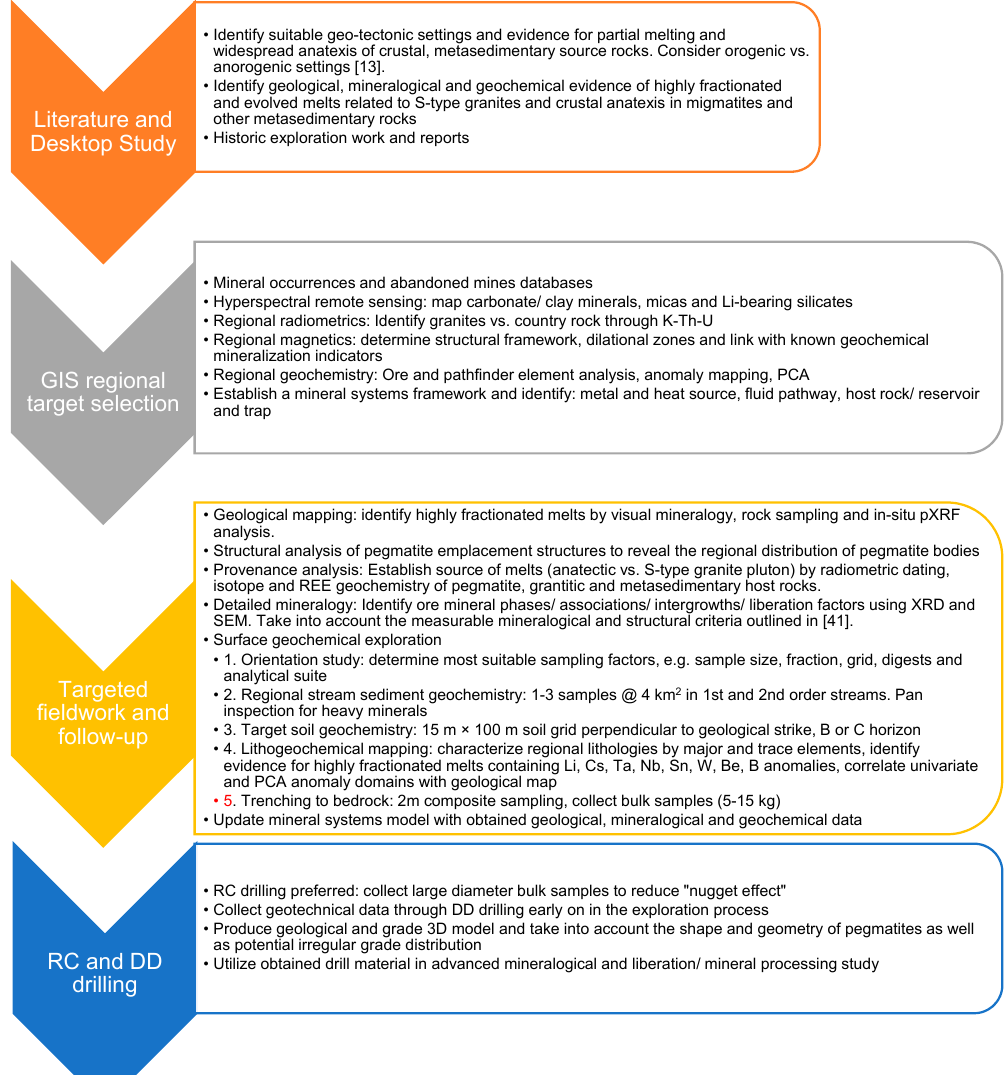
Figure 4. Workflow for early-stage LCT pegmatite target generation, definition and testing.